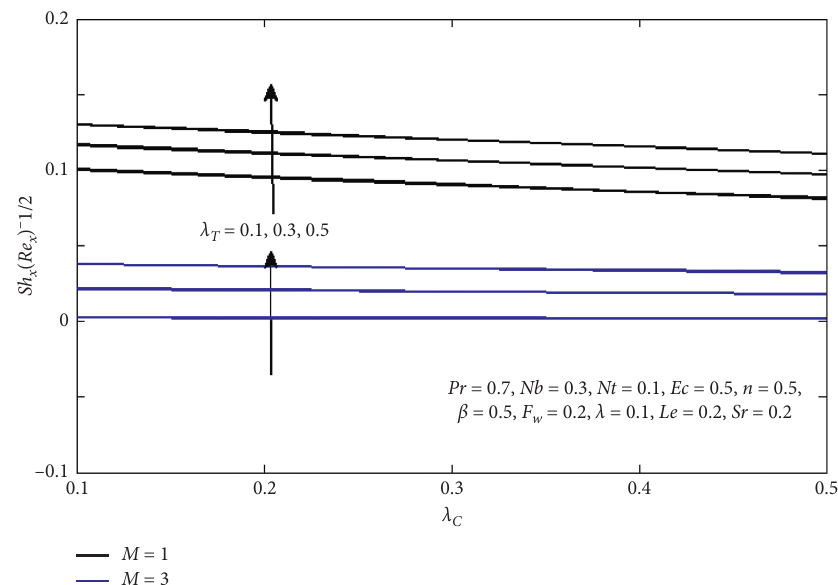
Figure 25: Variation of Sh